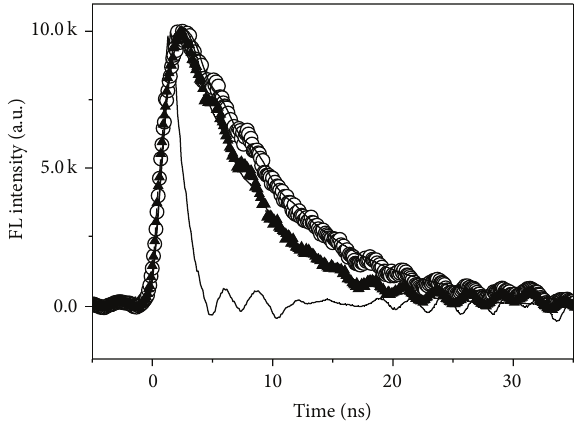
Figure 3: Typical fluorescence decay signals ( 𝜆 fitted lines of PA (o) and HPA ( 󳵳 ); IRF indicates the instrumental response function (solid thin